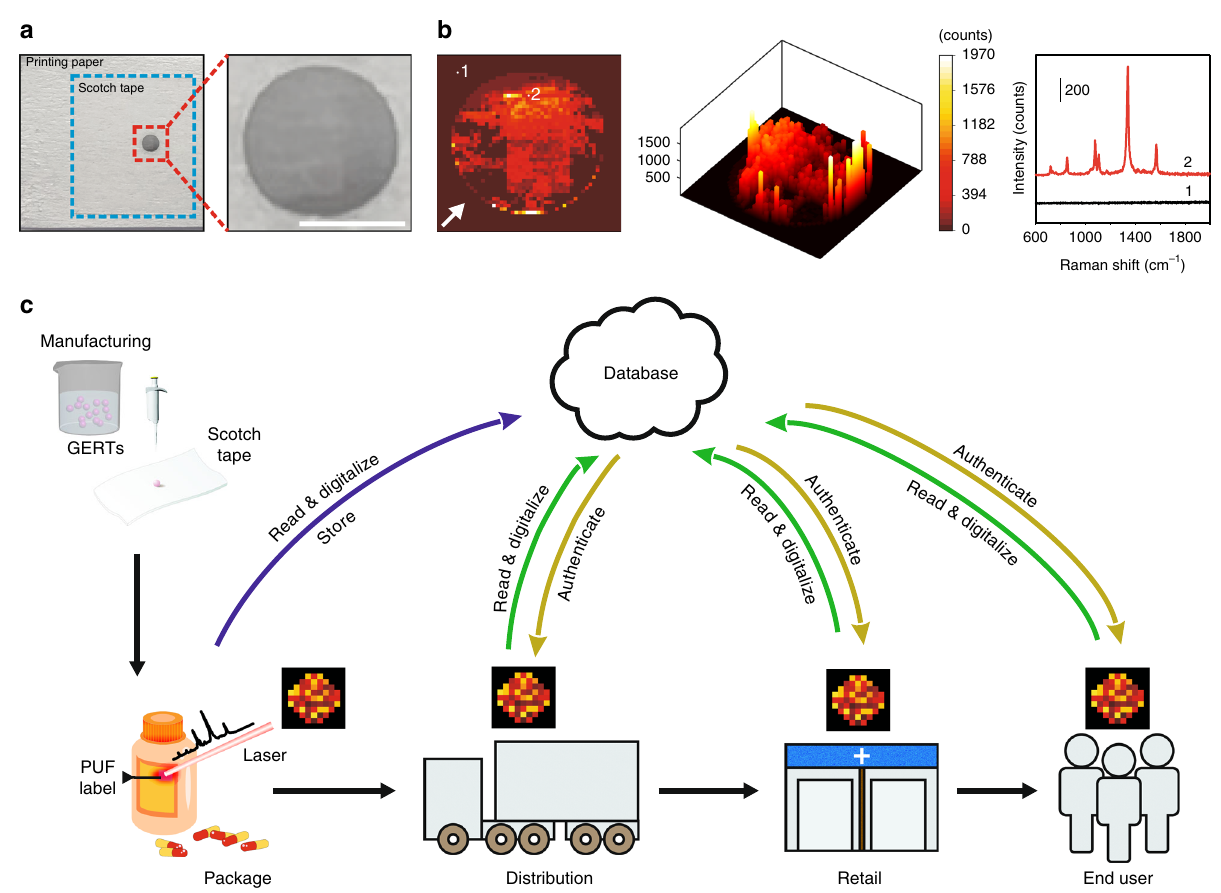
Fig. 7 Demonstration of Raman PUF labels and their utilization in an anticounterfeiting system. a A PUF label fabricated using 4-NBT GETRs on Scotch tape and b the corresponding 2D and 3D plots of the readout by high-resolution (50 × 50 pixels) Raman mapping. The background (Scotch tape and the printing paper) exhibits a negligible Raman signal (e.g., point 1) and the PUF label emits strong signals from its 4-NBT GERTs (e.g., point 2). Scale bar in panel a is 1 mm. c Schematic illustration of Raman PUF labels applied in the supply chain with an anticounterfeiting system. The composition of fi gure ( c ) refers to the ref. 16